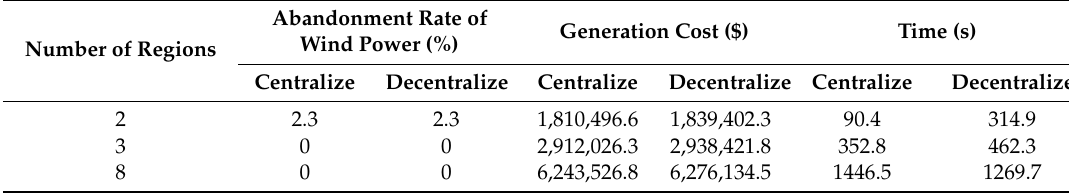
Table 3. Comparison of the results of 2, 3, and 8 regional